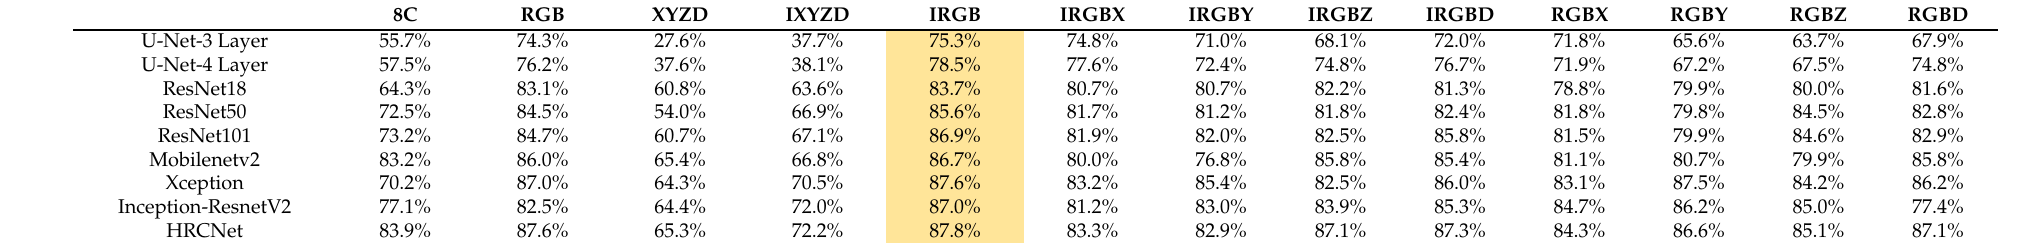
Table 5. OA of seven networks regarding different combinations of channels (the highest OA for each network is marked as yellow).